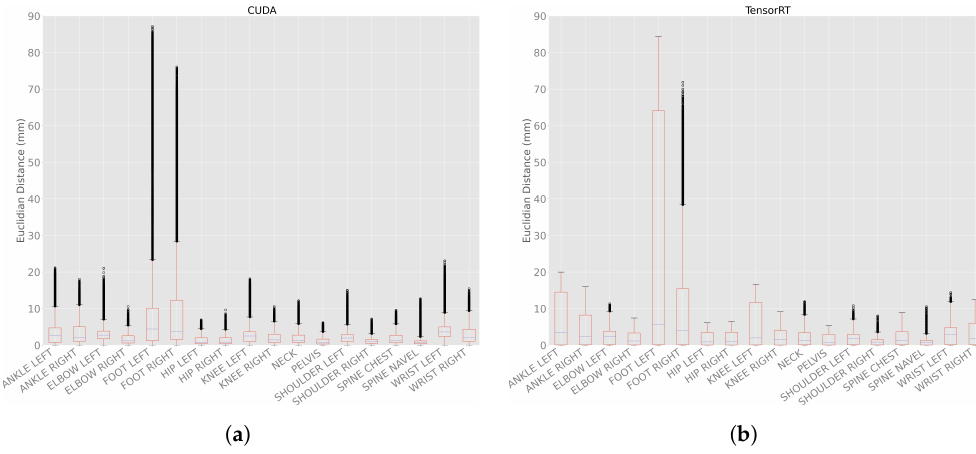
Figure 11. Euclidean distance with 100 body tracking runs using CUDA and TensorRT. ( a ) Euclidean distances with 100 body tracking runs using CUDA. ( b ) Euclidean distances with 100 body tracking runs using